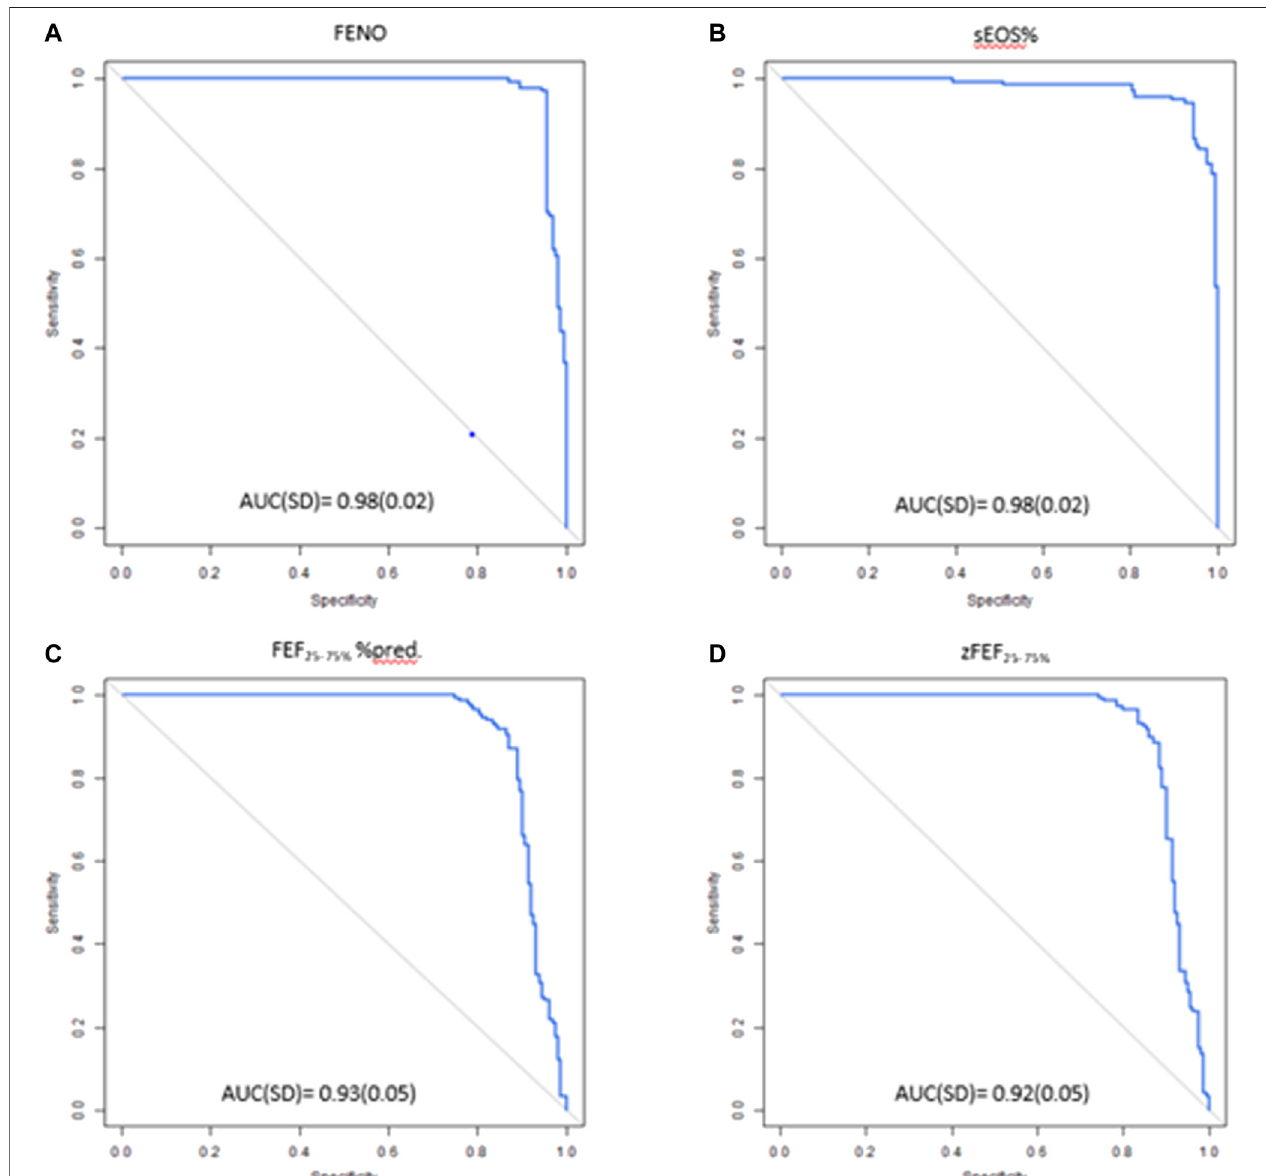
FIGURE 1 | ROC curves of (A) F E NO (B) sEOS% (C) FEF 25 – 75% %pred (D) zFEF 25 – 75% in predicting positive BHR. ROC, receiver operating characteristic; F E NO, fractional exhaled nitric oxide; sEOS%, percentage of eosinophils in induced sputum; FEF 25 – 75% , forced expiratory fl ow at 25 – 75% of forced vital capacity: AUC, Area under the curve; SD standard